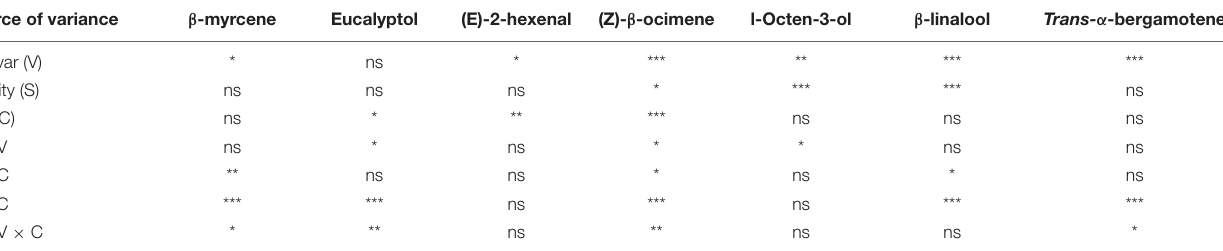
TABLE 6 | Analysis of variance (ANOVA) and mean comparisons for the relative abundance (%) of major aroma volatile components [ β -myrcene, eucalyptol, (E)-2-hexenal, (Z)- β -ocimene, 1-octen-3-ol, β -linalool, and trans- α -bergamotene] in Green and Red cultivars grown hydroponically under iso-osmotic salinity treatments and harvested in two sequential